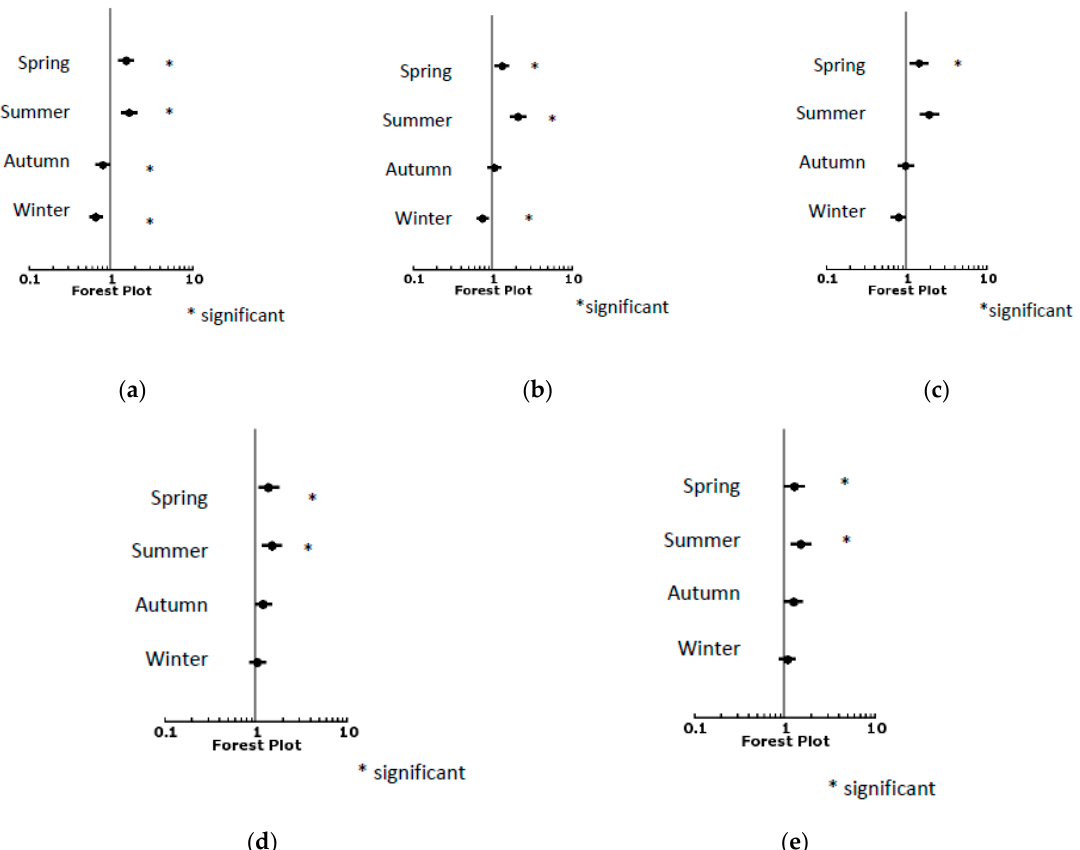
Figure 6. ( a – e ) Point in time of symptoms. ( a ) Time of symptoms associated with spring bloomers; ( b ) Time of symptoms associated with summer bloomers; ( c ) Time of symptoms associated with autumn bloomers; ( d ) Time of symptoms asso- ciated with mites; ( e ) Time of symptoms associated with mold. Table 1. Spring bloomers.